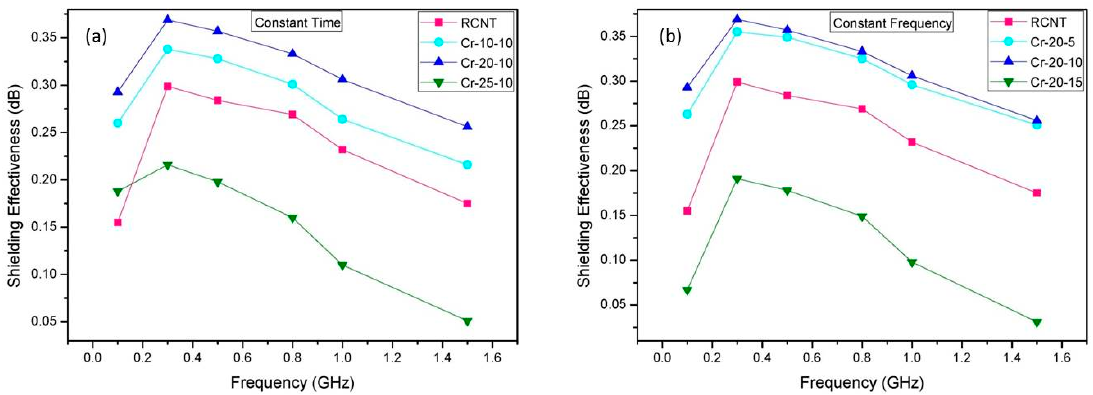
Figure 9. Electromagnetic interference (EMI) shielding effectiveness (SE) data of the different CNT/PMMA composites: ( a ) RCNT, Cr-10-10, Cr-20-10, and Cr-25-10; and ( b ) RCNT, Cr-20-5,